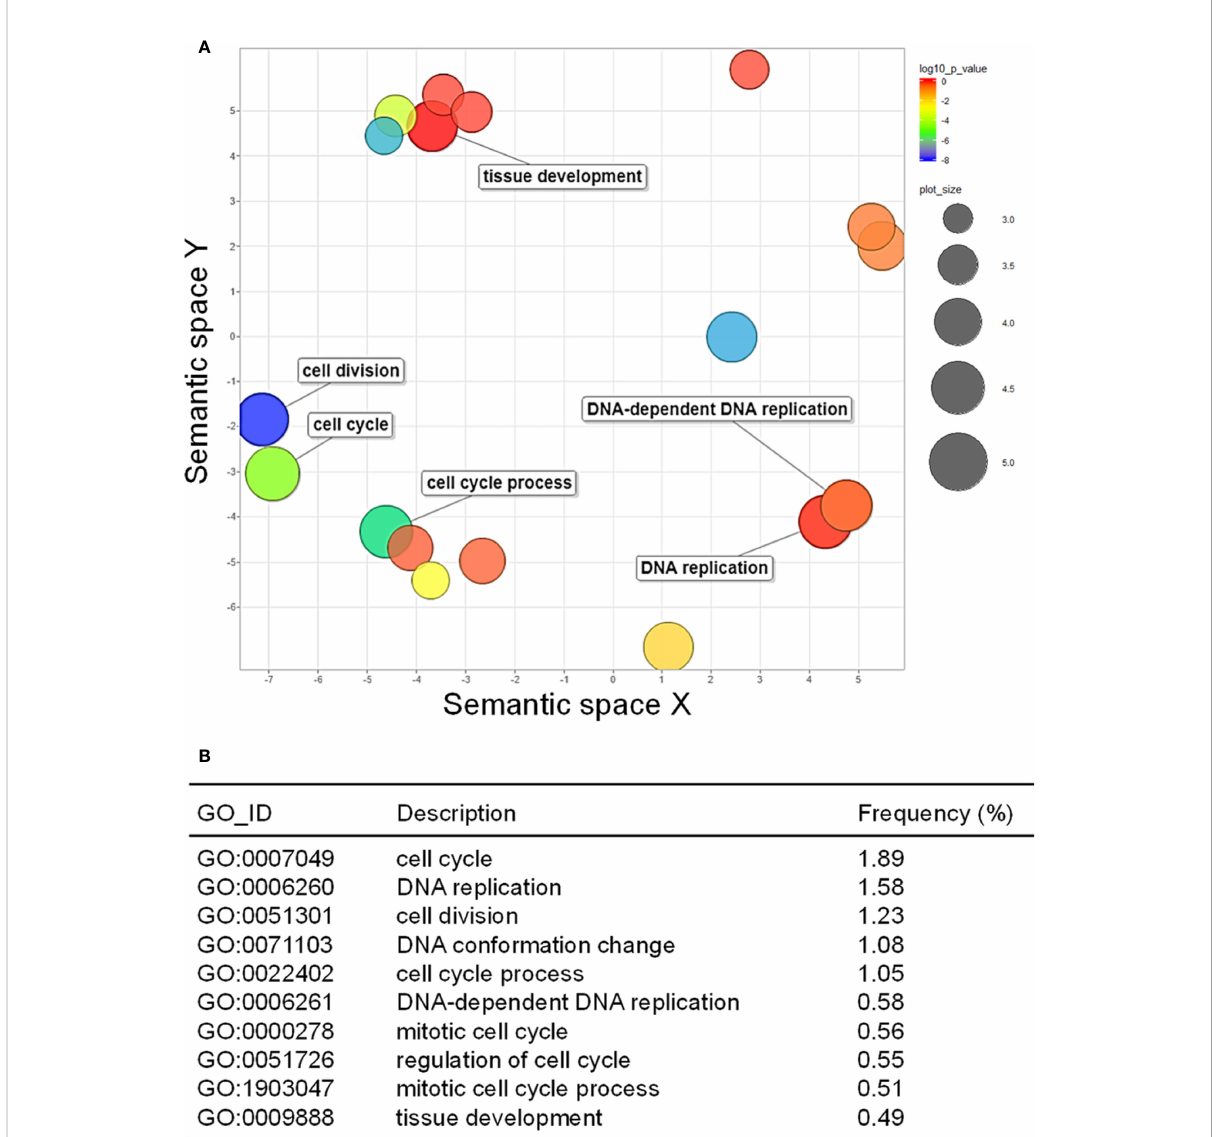
FIGURE 3 Gene ontology (GO) enrichment of downregulated differentially expressed genes (DEGs). (A) GO enrichment in the biological process category, as visualized using REVIGO. The scatter plot shows the signi fi cance of GO terms in a two-dimensional space. Multi-dimensional scaling was applied to a matrix of GO terms to calculate semantic similarities. Colors indicate the P -value for the false discovery rate, and circle sizes represent the frequency of the GO term. (B) Top 10 GO terms enriched for the downregulated DEGs in response to CMV